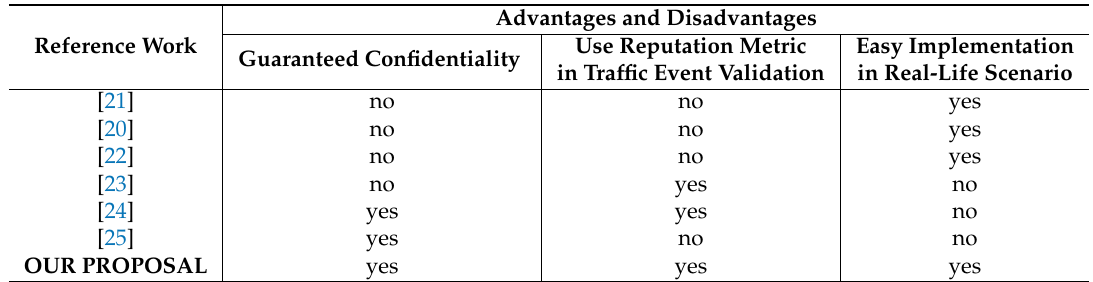
Table 1. Comparative analysis of related